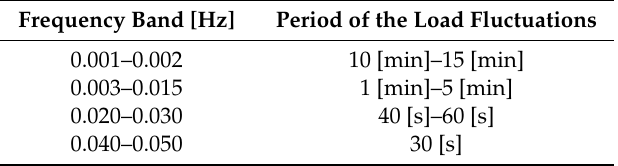
Table 2. Frequency bands for the period of load